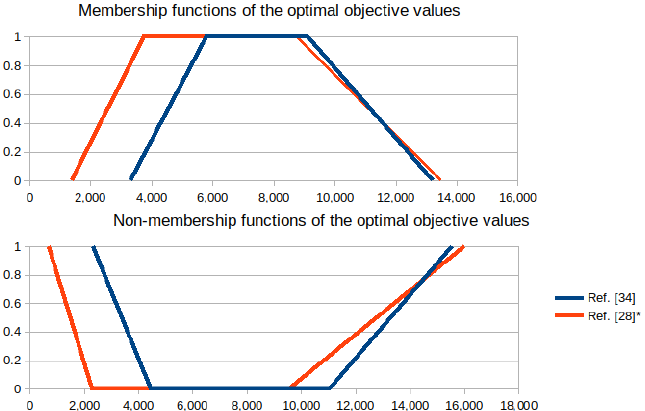
Figure 3. Graphic representation of the results reported in Table 1, example 2. Symbol ∗ marks the reference that introduced the approach that comply to the extension